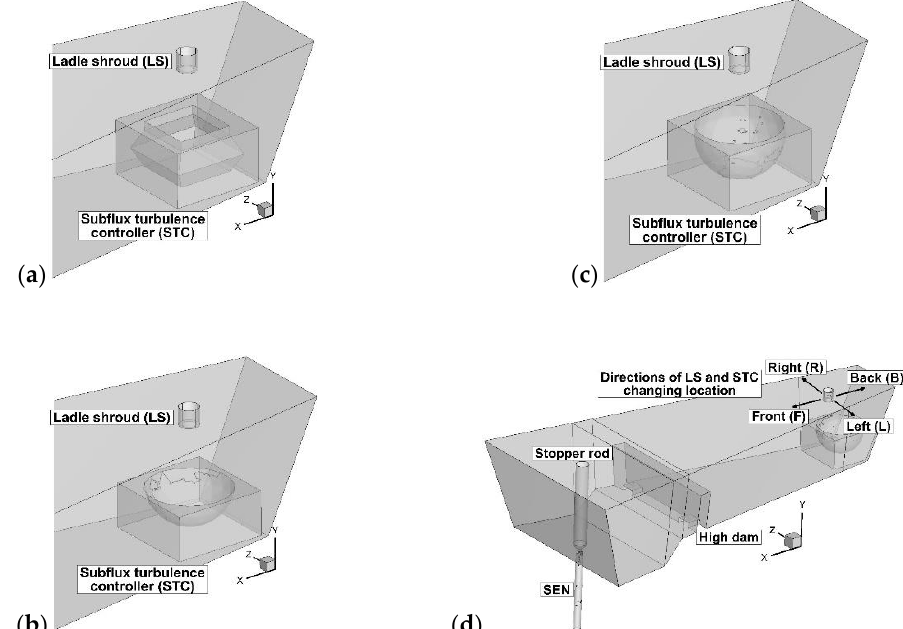
Figure 1. One strand slab tundish: ( a ) standard position of subflux turbulence controller (STC) No. 1, ( b ) standard position of STC No. 2, ( c ) standard position of STC No. 3, ( d ) case with high dam and proposed position of STC No. 3.